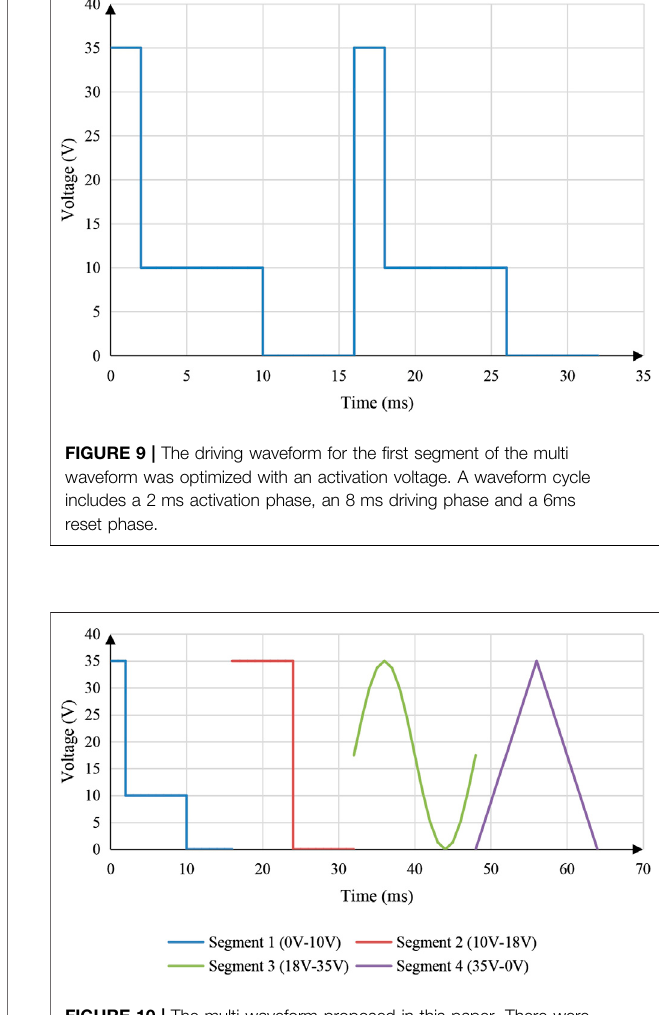
FIGURE 10 | The multi waveform proposed in this paper. There were four segments in total. The fi rst segment was from 0 to 10 V, which was a square wave optimized with an activation voltage. The second segment was from 10 to 18 V, which was a square wave. The third segment was from 18 to 35 V, which was a sine wave. The fourth segment was from 35 to 0 V, which was a triangle